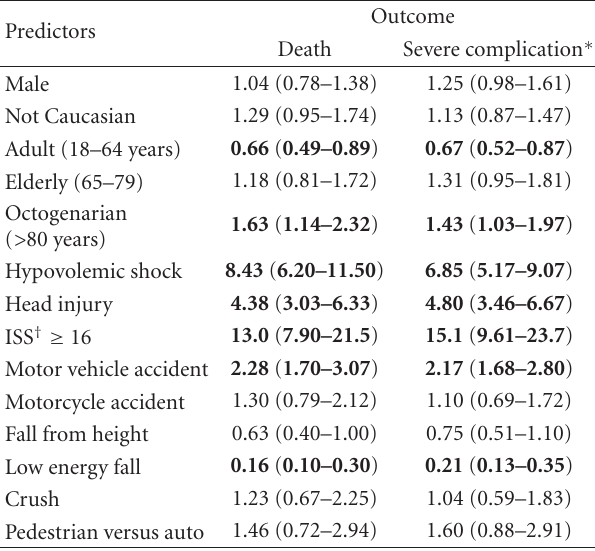
Table 4: Bivariate analysis for the population with isolated, closed, and severe pelvic fractures (AIS ≥ 3), comparing predictors upon arrival to the emergency department with the outcomes death and severe complication (odds ratios and 95% confidence intervals), n = 31,475.